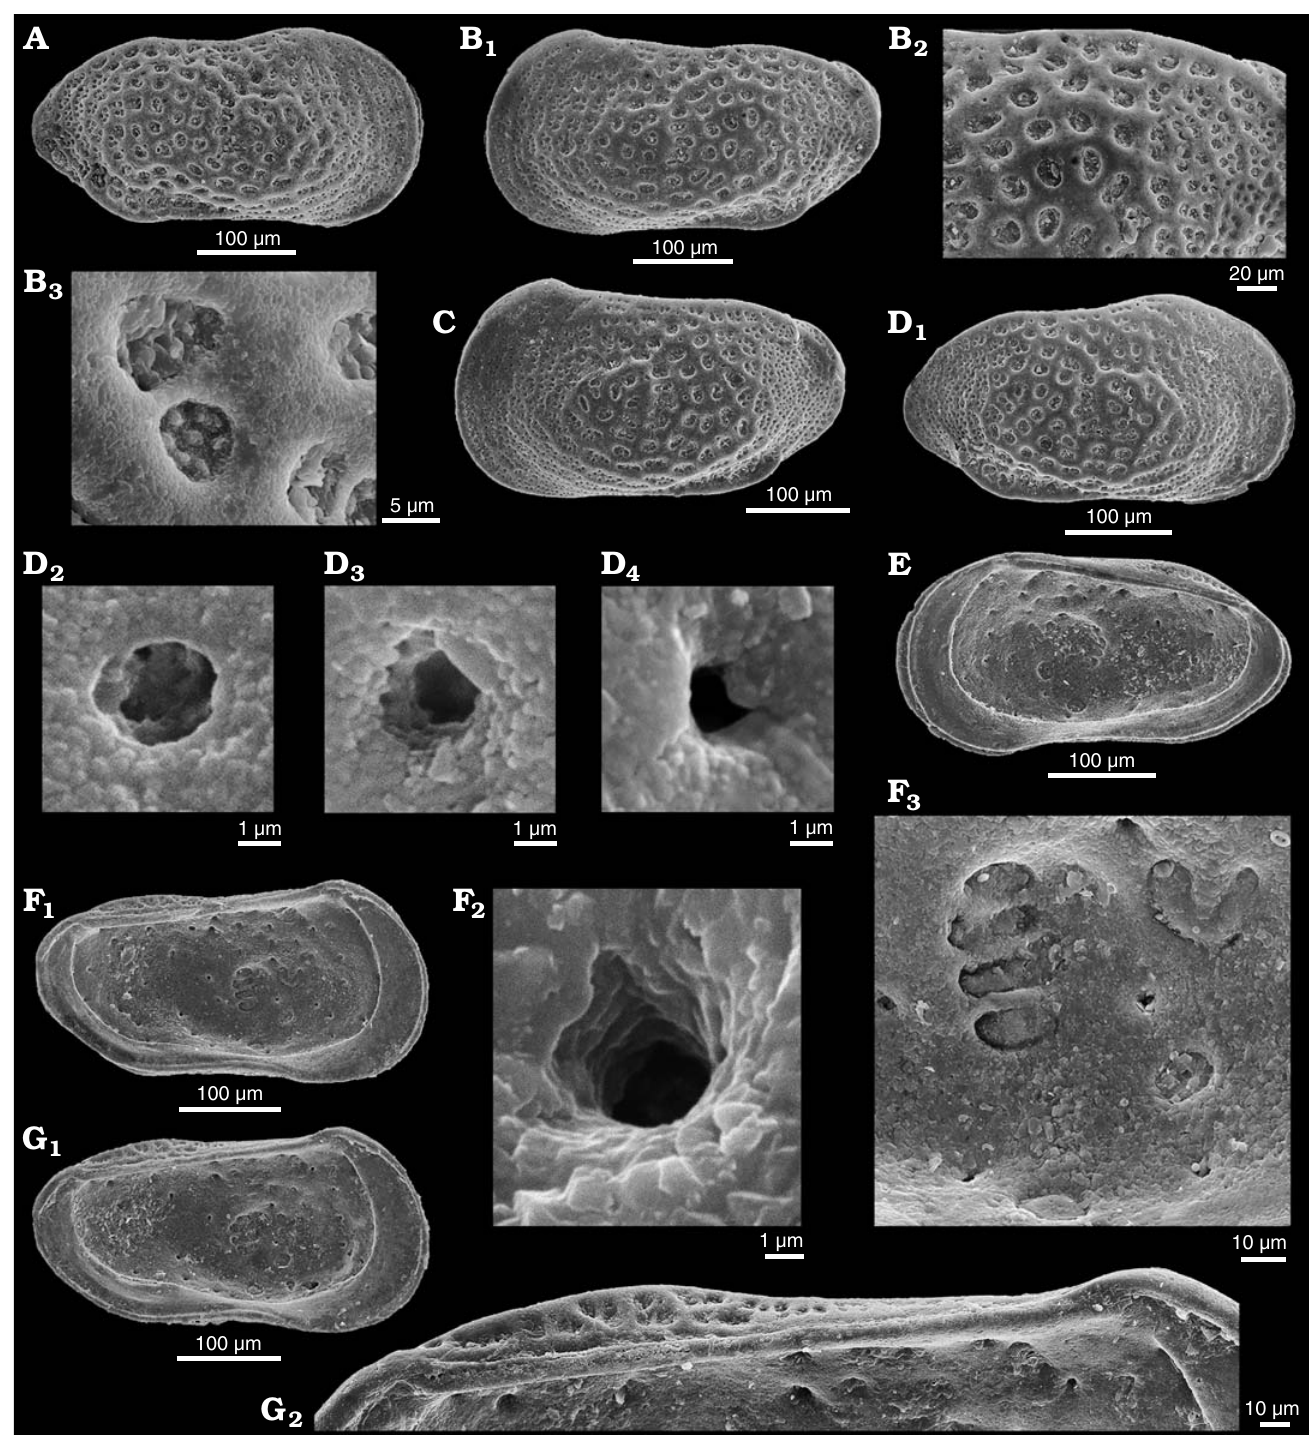
Fig. 20. Cytherid ostracod Dolocythere amphistiela sp. nov. from Borehole Rodewald WA4, 187 m, NW Germany Leymeriella tardefurcata Zone, Lower Albian. A . Paratype, SMF Xe 23760, male right valve in external view. B . Holotype, SMF Xe 23761, male left valve in external view (B 1 ), dorsal-posterior area (B 2 ), ornamentation (B 3 ). C . Paratype, SMF Xe 23762, female left valve in external view. D . Paratype, SMF Xe 23763, female right valve in external view (D 1 ), small StPC (cf. micro sieve-type normal pore canals StPC-m) (D 2 , D 3 ), simple pore (D 4 ). E . Paratype, SMF Xe 23764, female right valve in internal view. F . Paratype, SMF Xe 23765, male left valve in internal view (F 1 ), small StPC (cf. StPC-m) (F 2 ), muscle scars (F 3 ). G . Paratype, SMF Xe 23766, male left valve in internal view (G 1 ), hinge (G 2 Interior : Internally the valves show depressions that match the positions of StPC externally. Marginal zone well